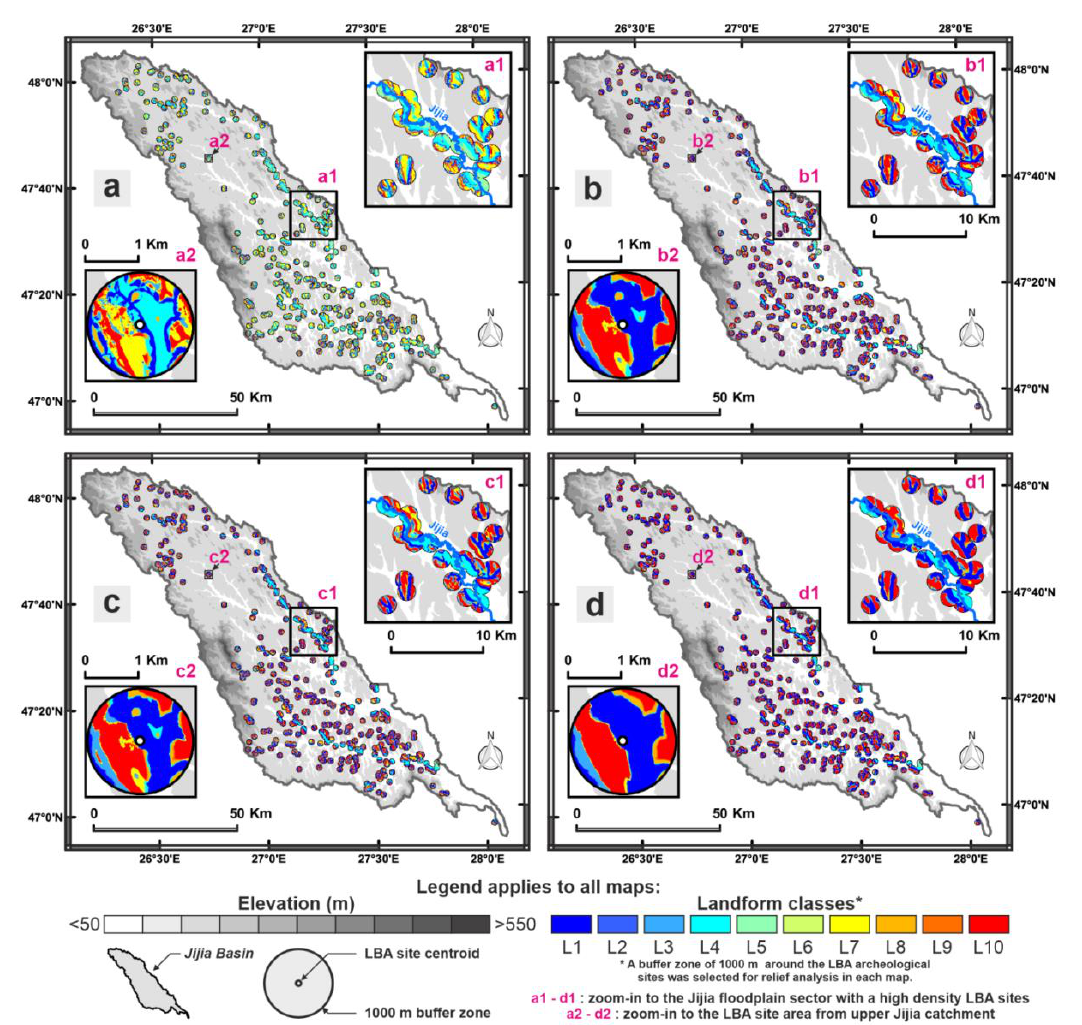
Figure 6. Landform classification based on TPI-derived DEV of the LBA archaeological sites (Noua Culture) in the Jijia catchment, with ten landform types (see Table 2); the relief analysis was provided for the combined of two TPI-derived DEV neighborhood sizes ( a ) 100 and 600 m, ( b ) 300 and 1200 m, ( c ) 300 and 2000 m and ( d ) 600 and 2000 m. Table 4. Number of LBA archaeological sites occurring over ten specific landform classes in the Jijia catchment (see Figure 6).